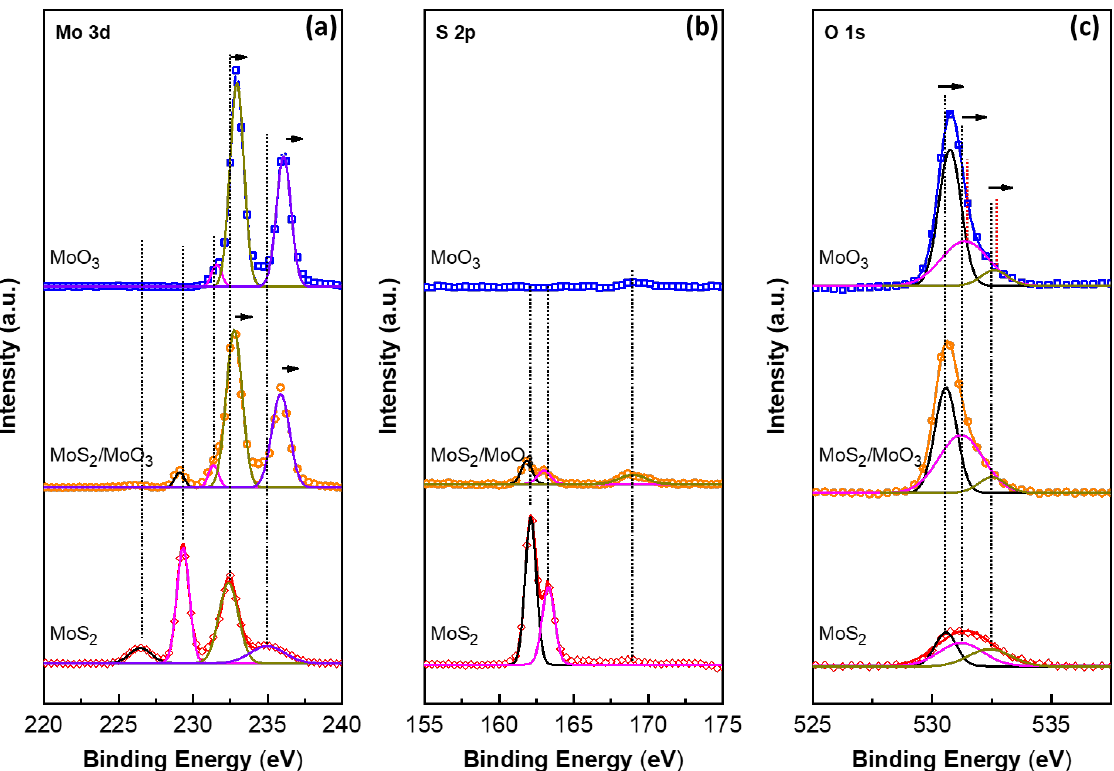
Figure 3. ( a ) Mo 3d, ( b ) S 2p, and ( c ) O 1s XPS spectra of MoS 2 , MoO 3 @MoS 2 , and MoO 3